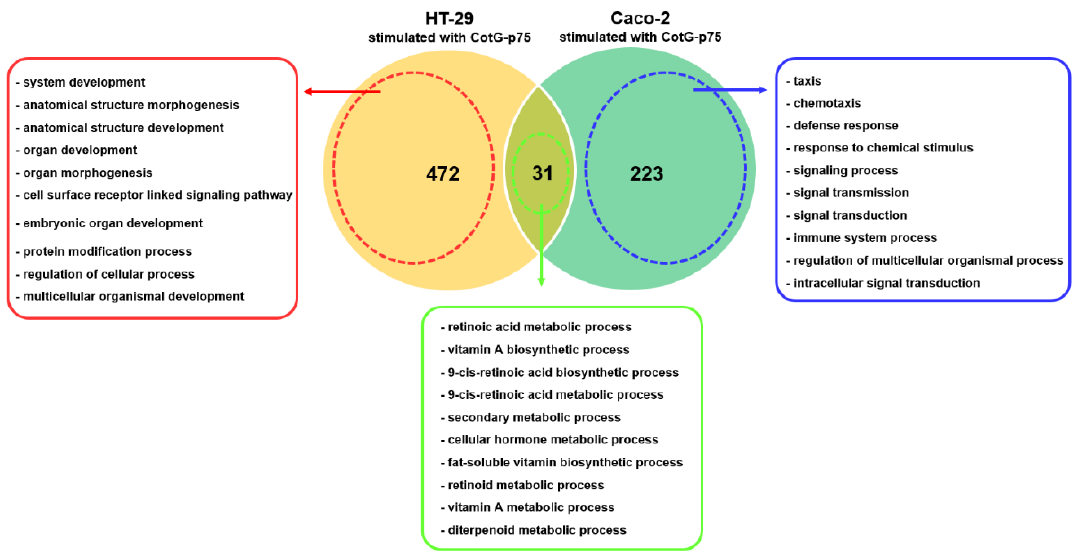
Figure 13. Numbers of common and unique DEGs in HT-29 and Caco-2 cells stimulated with CotG- p75. Top 10 gene ontology terms of common and unique DEGs in HT-29 and Caco-2 are presented in the green, red, and blue boxes.